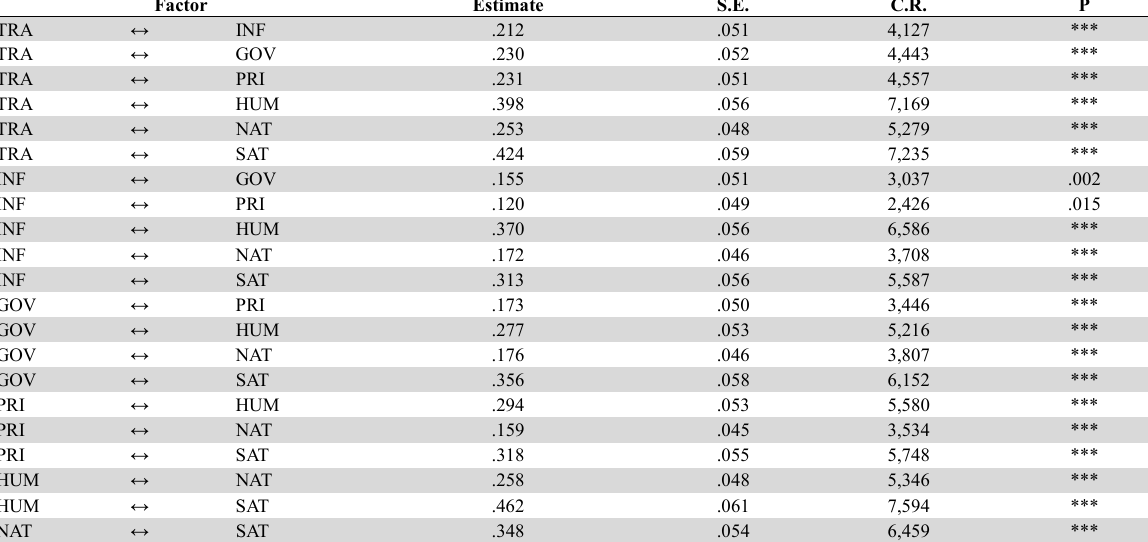
Coefficient of correlation, covariance between variables